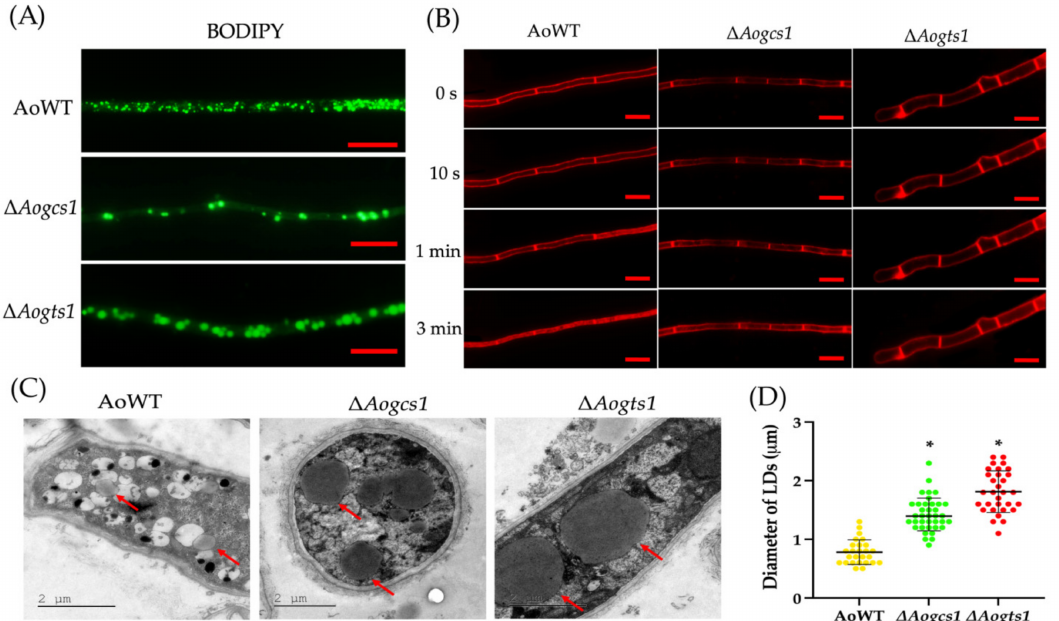
Figure 6. Effects of AoGcs1 and AoGts1 on lipid storage and endocytosis in mycelia. ( A ) Mycelia of the WT and mutant strains were stained with the fluorescent dye BODIPY. Bar: 10 = µ m. ( B ) Endocy- tosis in the WT and mutant strains at different times. Bar: 10 = µ m. ( C ) Lipid droplets (LDs) were observed in the WT and mutant strains by transmission electron microscope. The arrows show the LDs. ( D ) Comparison of the diameters of the LDs in more than 30 cells in electron micrographs of mutant strains and the WT strain. The asterisk indicates a significant difference between the mutants and the WT strain (Tukey’s HSD, p < 0.05).